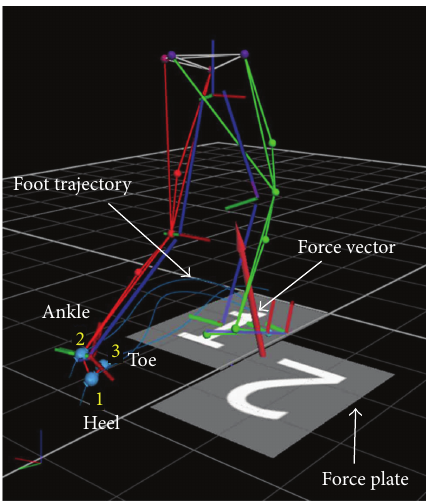
Figure 2: 3D simulation of lower limb trajectory of the affected leg with respect to the attached markers.